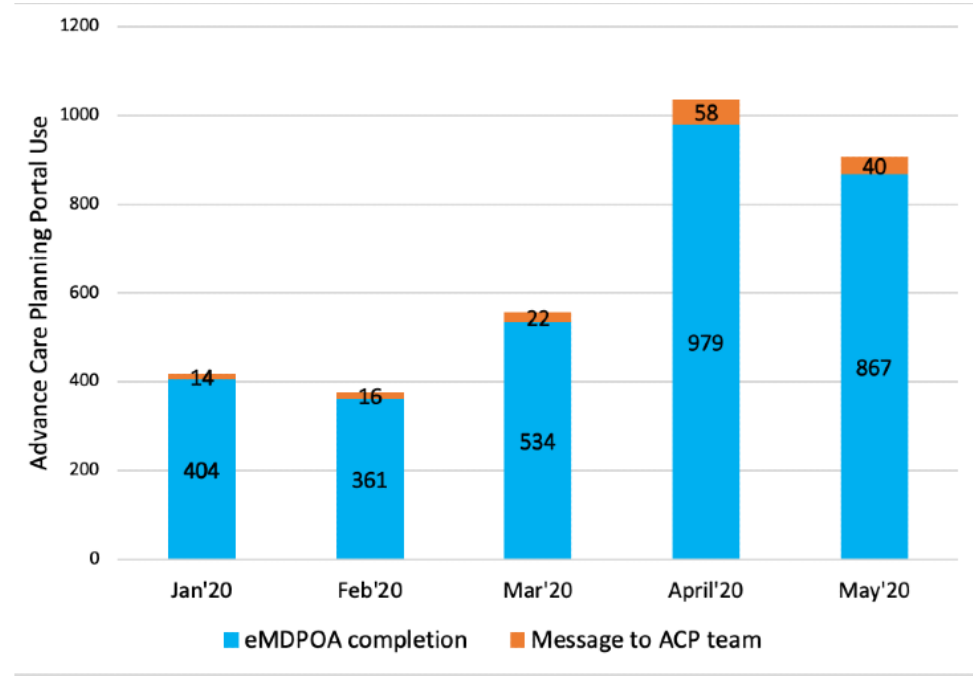
Figure 2. Monthly use of the UCHealth advance care planning portal during the coronavirus disease pandemic by type of portal use. ACP: advance care planning; eMDPOA: electronic medical durable power of attorney.